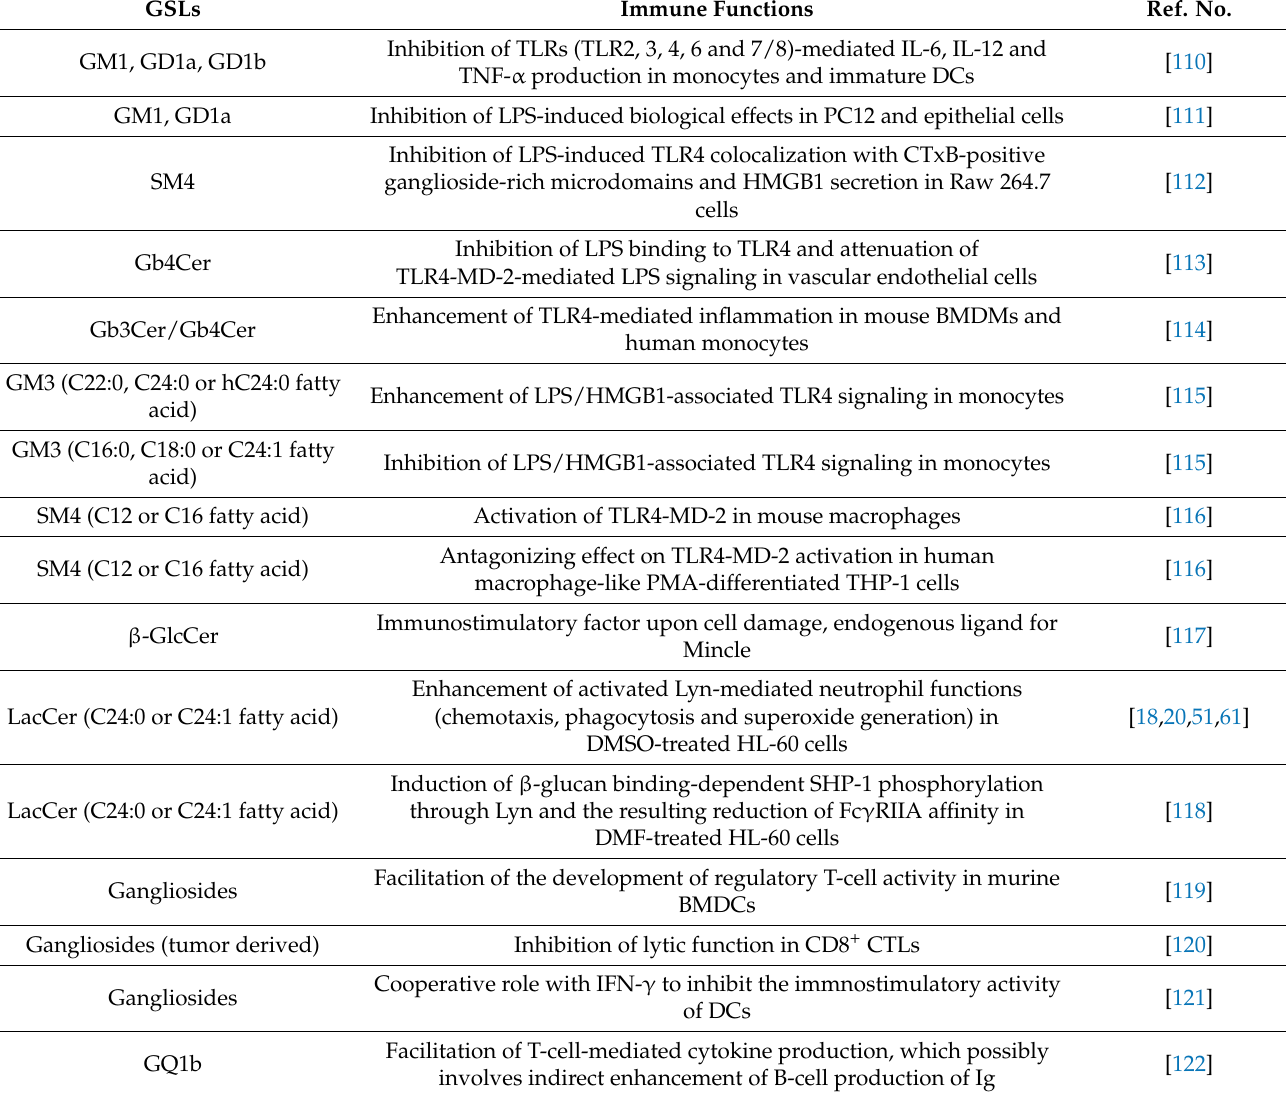
Table 2. GSLs as immune